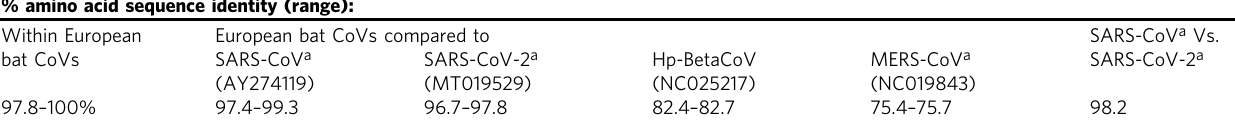
Table 1 Amino acid identities of a partial RdRp fragment of European bat coronaviruses and prototype betacoronaviruses for species